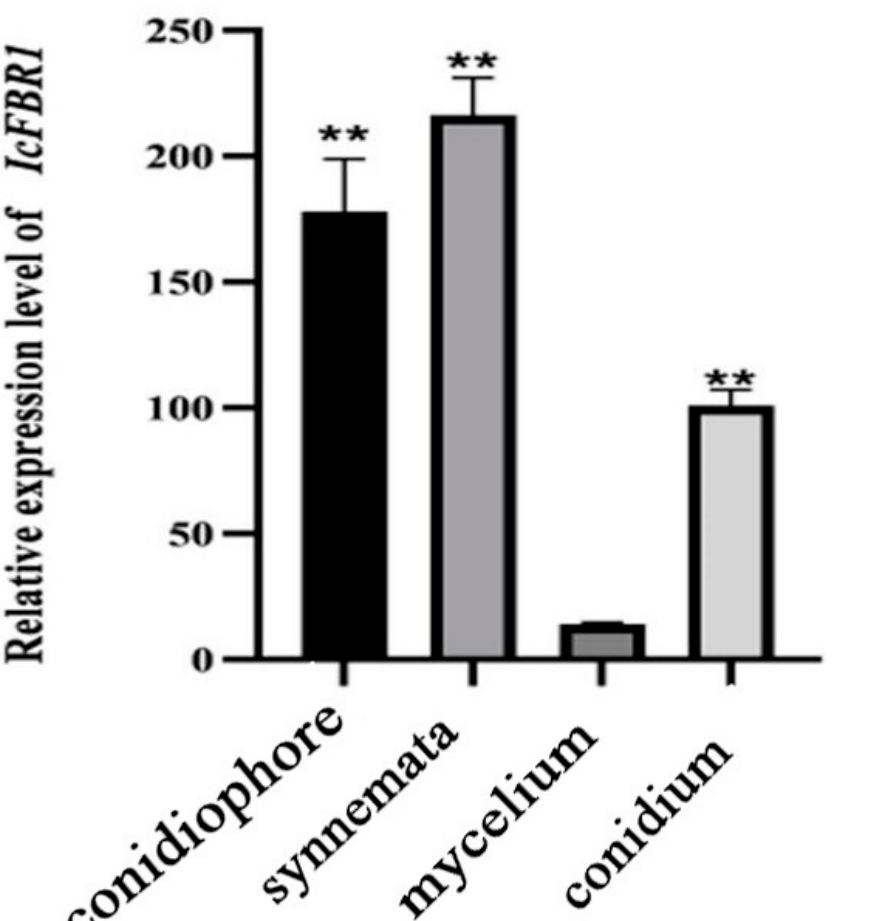
Figure 5. Expression of IcFBR1 gene in I. cicadae wild-type strain. Gene expression of IcFBR1 in a different part of I. cicadiae . “**” indicate a significant difference at p < 0.01. All tests were repeated at least twice with three replicates of each treatment.